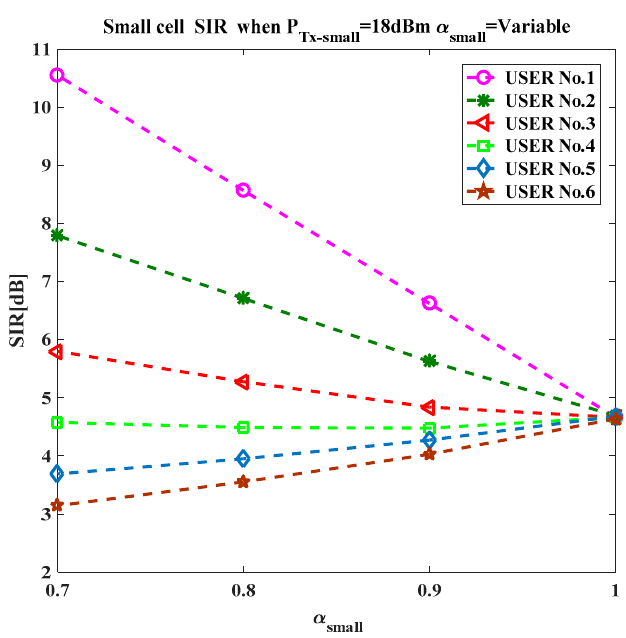
α small in the homogenous small cell